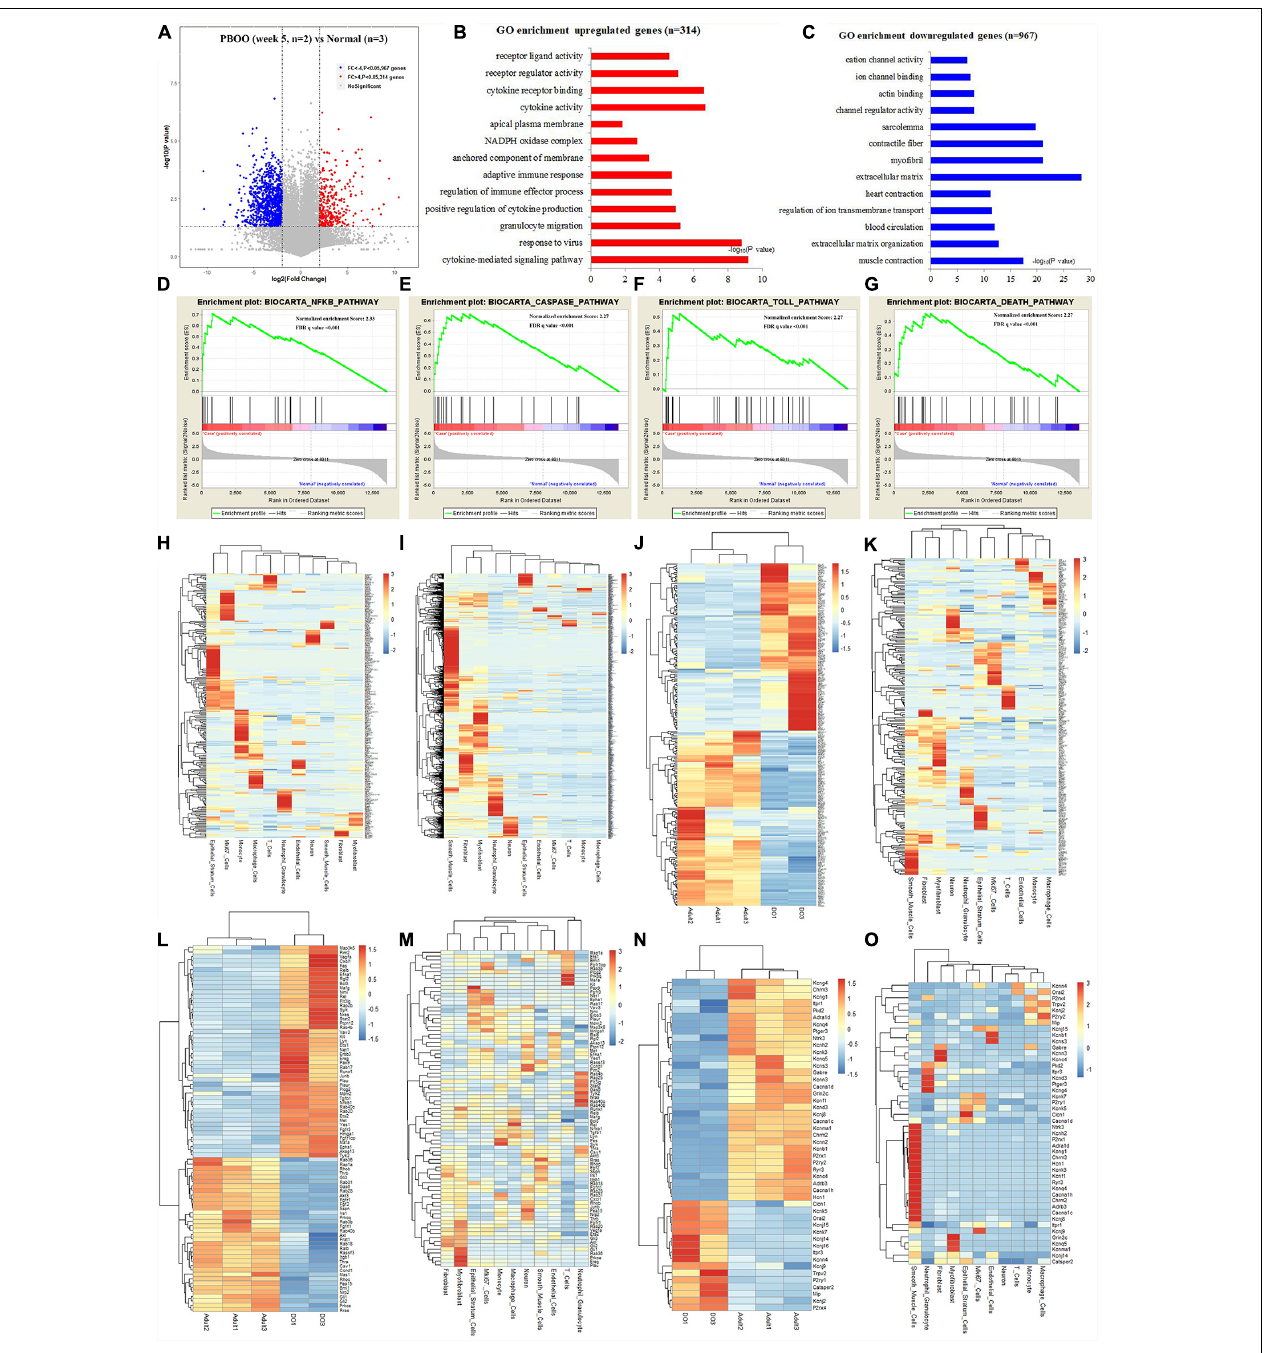
FIGURE 4 | RNA-seq analysis comparing bladder tissues of week 5 PBOO and normal rat. Volcano plot (A) show 314 high expression genes (red color) and 967 low expression genes (blue color) in week 5 PBOO rat bladder tissues ( n = 2) compared with normal ( n = 3). GO enrichment analysis of high expression genes ( n = 314) in PBOO rat bladder tissue (B) . GO enrichment analysis of low expression genes ( n = 967) in PBOO rat bladder tissue (C) . GSEA analysis show four major biocarta pathway changes in PBOO rat bladder tissues compared normal (D–G) . Heatmap plot show 314 high expression gene were distributed in different bladder cell (H) . Heatmap plot show 967 low expression gene were distributed in different bladder cell (I) . Picking up 250 high and low expressed transcript factors (J) in PBOO rat bladder, and enrichment in different cell types in bladder tissues (K) . Picking up 83 high and low expressed growth factors (L) in PBOO rat bladder, and enrichment in different cell types in bladder tissues (M) . Picking up 48 high and low expressed ion channel genes (N) in PBOO rat bladder, and enrichment in different cell types in bladder tissues (O) .